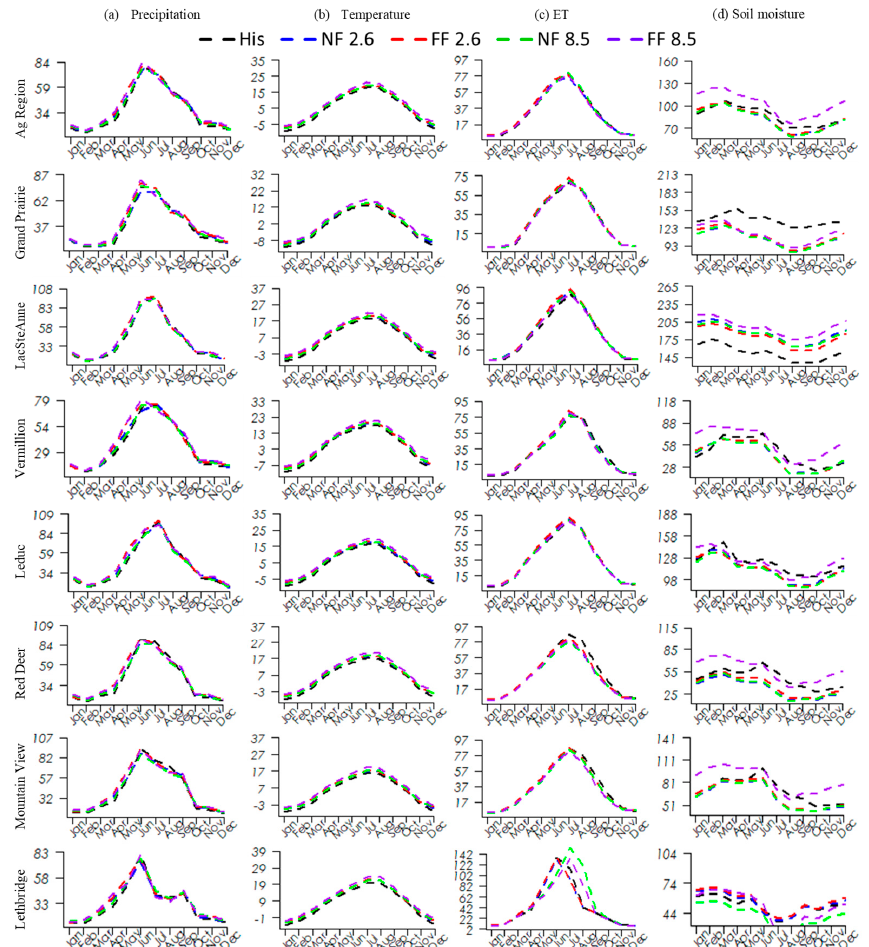
Figure 7. Long-term average monthly ( a ) precipitation, ( b ) temperature ( c ) evapotranspiration (ET), and ( d ) soil moisture in the study area and seven selected counties. ‘Ag Region’ indicates the entire study area.